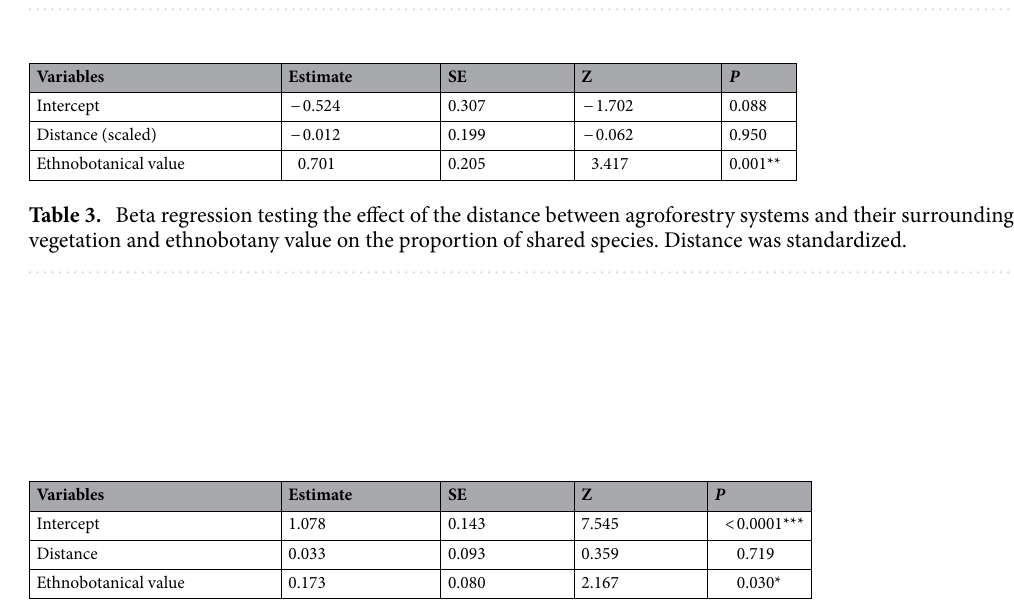
Table 2. Parameterized models and selection of appropriate models using information theoretic approach. ΔAICc is the small sample corrected difference in Akaike Information Criterion (AIC) between each model and the lowest AIC value. df is the degree of freedom.